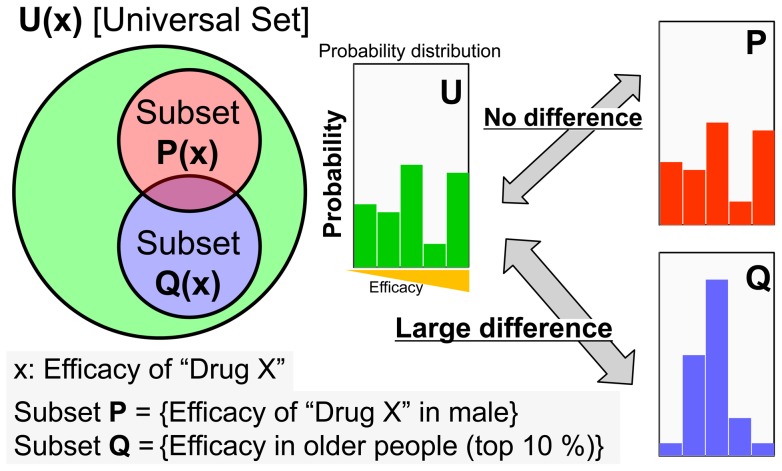
Outline of the calculation procedure used for the novel data-mining method.The purpose of data-mining is to search for candidate explanatory variables that may affect objective variables. The data-mining procedure comprises three steps; (1) Generation of U [the universal set] of an objective variable (x). This example shows that the objective variable is the efficacy of “Drug X”. (2) Generation of subsets from the universal set by the conditions that are defined based on explanatory variables. For example, subset P(x), is generated by the condition “male” based on the explanatory variable “sex”, while subset Q(x) is generated by the condition “older people (top 10%)” based on the explanatory variable “age”. (3) Identification of candidate explanatory variables, by measurement and visualization of the difference in the probability distribution (histogram shape) of a subset from the universal set, U(x). This example shows that the explanatory variable “age” may affect the drug efficacy, while “sex” does not.